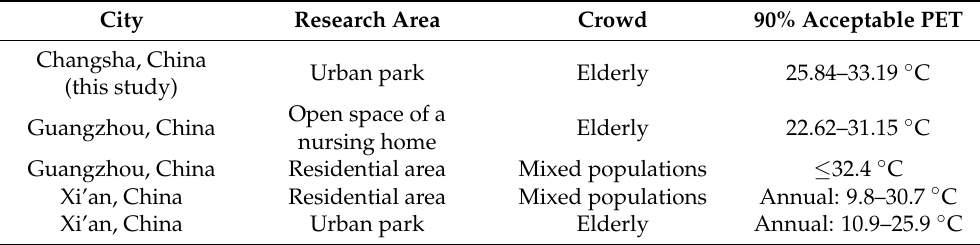
Table 9. Comparison of 90% acceptable PET range for residents of different